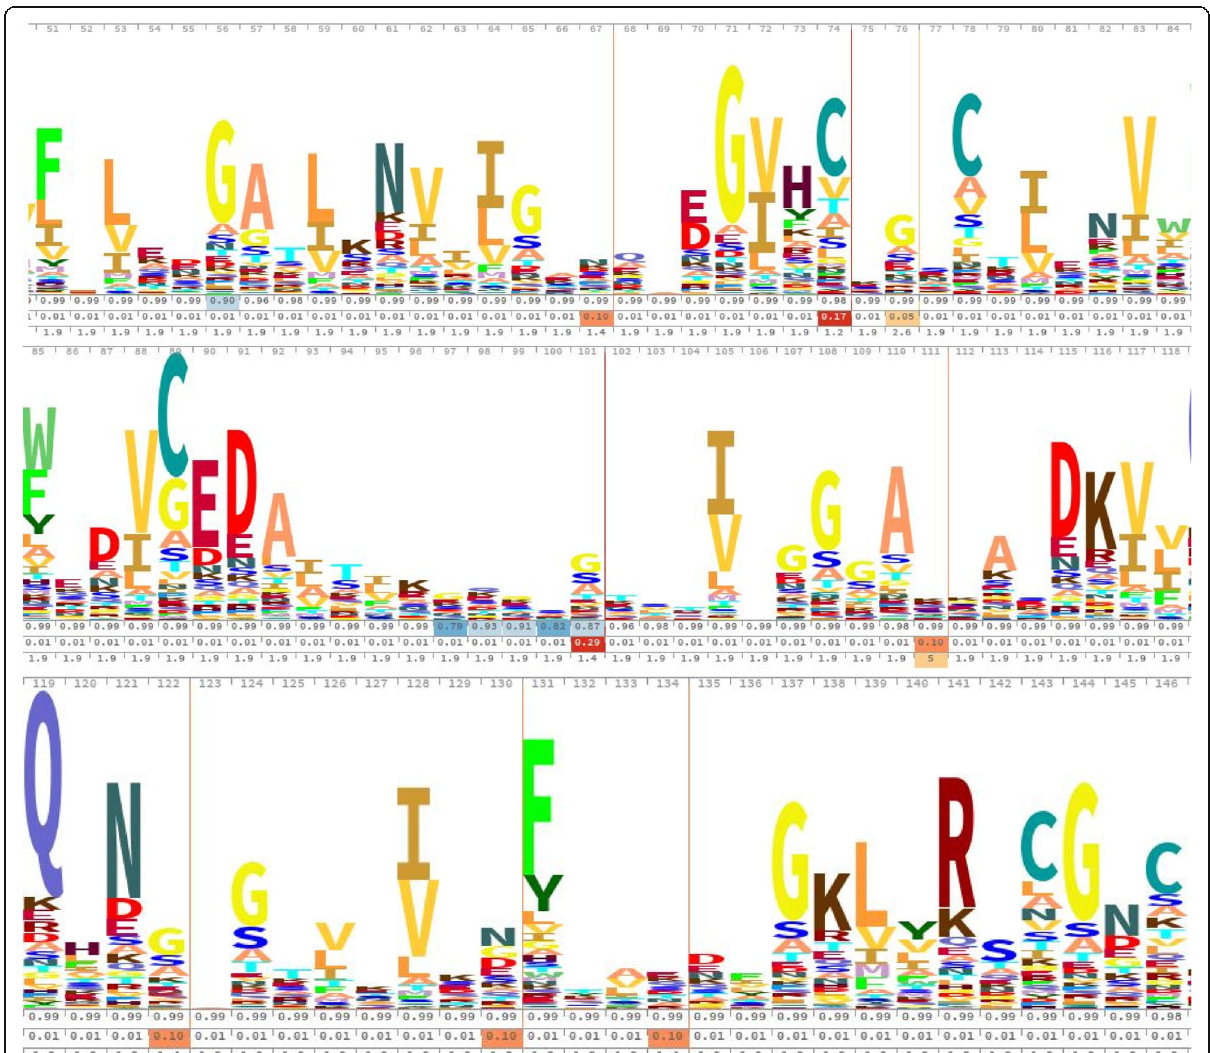
Fig. 1 HMM logo of Pfam03211 consensus sequence. Hidden Markov Model analysis revealed the presence of Pfam03211 domain in all PL3 sequences. The Pfam03211 Pectate Lyase Family 3 domain is 96 amino acids long and is typically located closer to the amino terminus of pectate lyase proteins. Analysis was conducted using the EMBL-EBI Pfam server (http://pfam.xfam.org/), using HMMER (Schuster-Böckler et al.